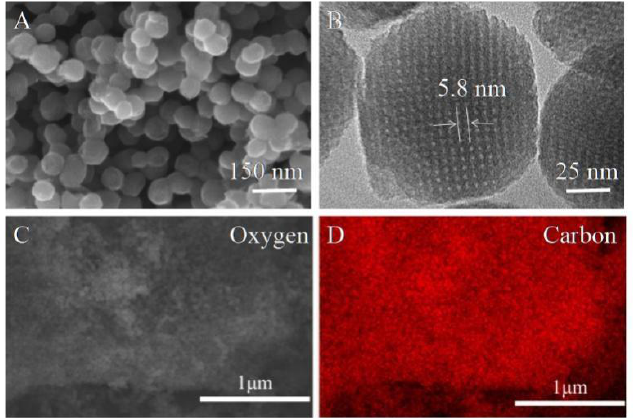
Figure 1. Structural characterization of annular surface MCNs. ( A ) SEM, ( B ) TEM, ( C ) element analysis of MCNs by EDS, and ( D ) carbon element analysis of MCNs.